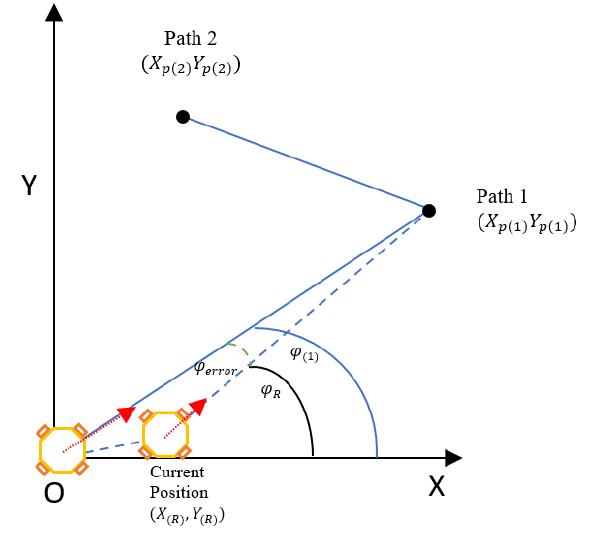
Figure 6. Error in Robot Movement Direction